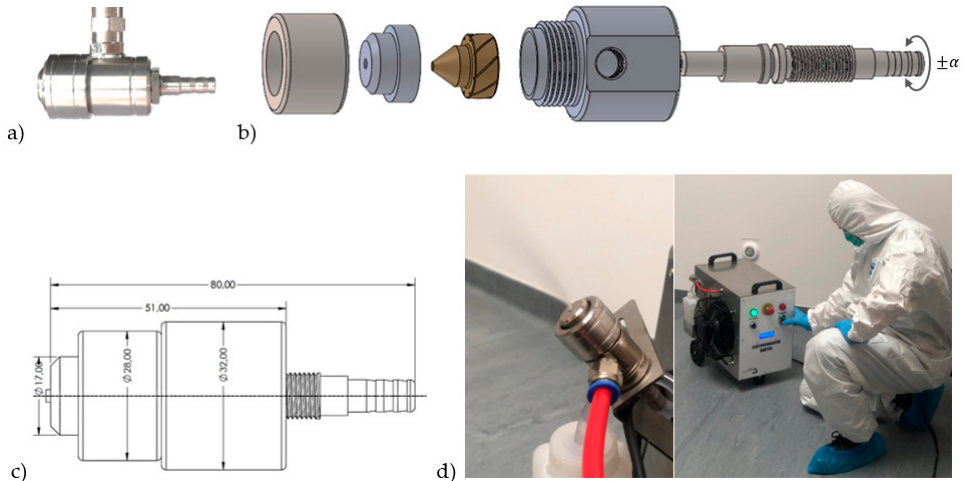
Figure 1. Nozzle applied in the research: ( a ) actual view, ( b ) 3D model, ( c ) main dimensions, ( d ) nozzle installed in BARTEK model 2 electofumigator.